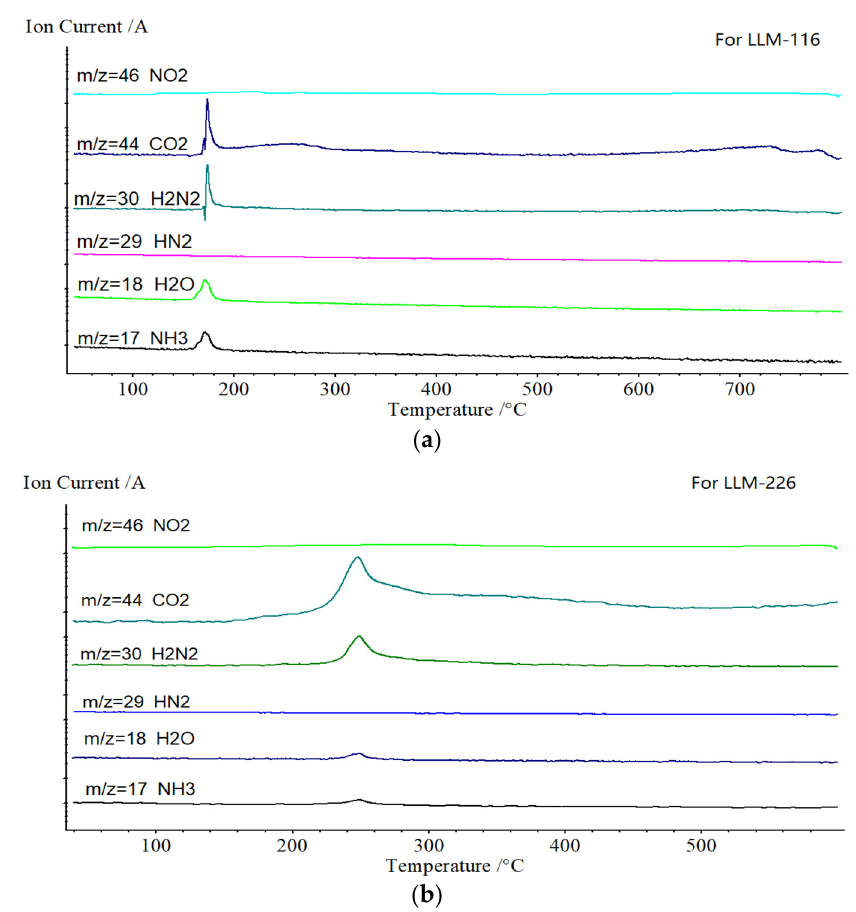
Figure 10. The Mass detections for the decompositions of LLM-116 ( a ) and LLM-226 ( b ).